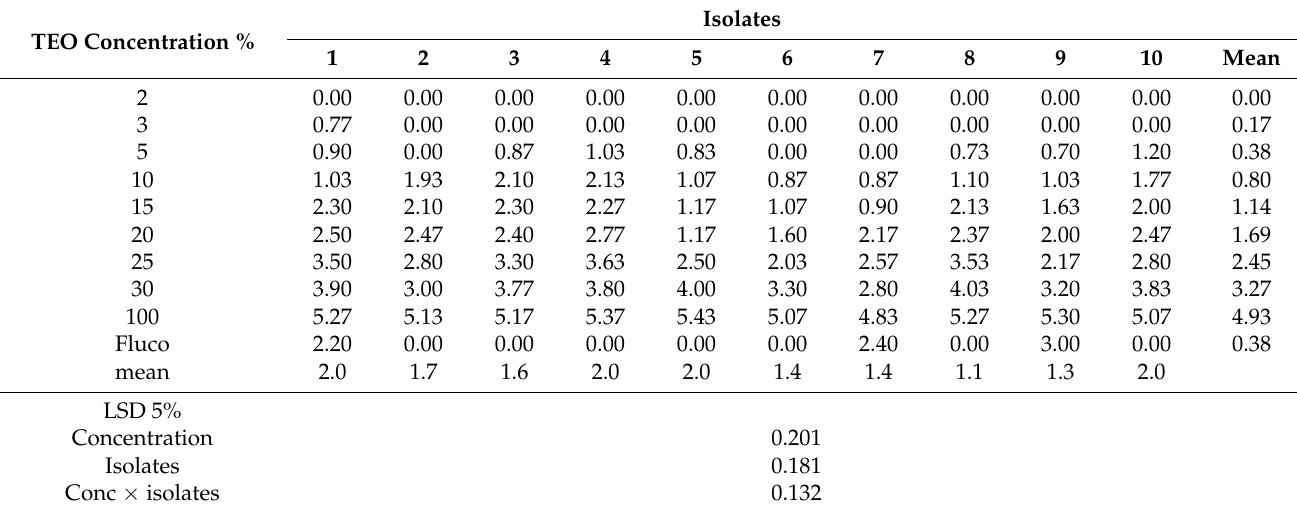
Table 3. Zone of inhibition (cm) of C. albicans isolates from vagina at different concentrations of thyme essential oil (TEO). TEO Concentration %